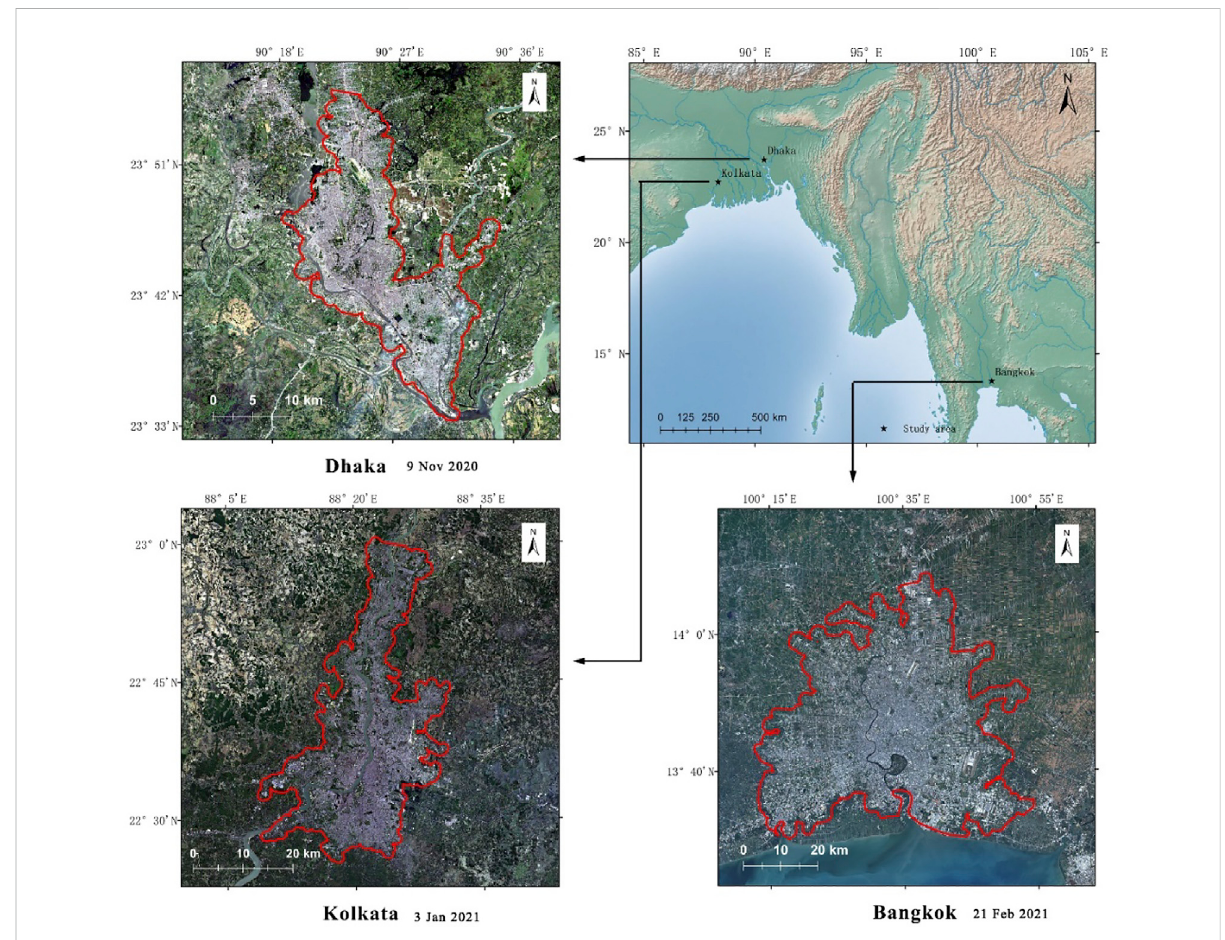
FIGURE 1 The geographic location of thestudy area. The redpolygons represent theurban functional boundary. The underlying satellite imagesare from Landsat-8 OLI